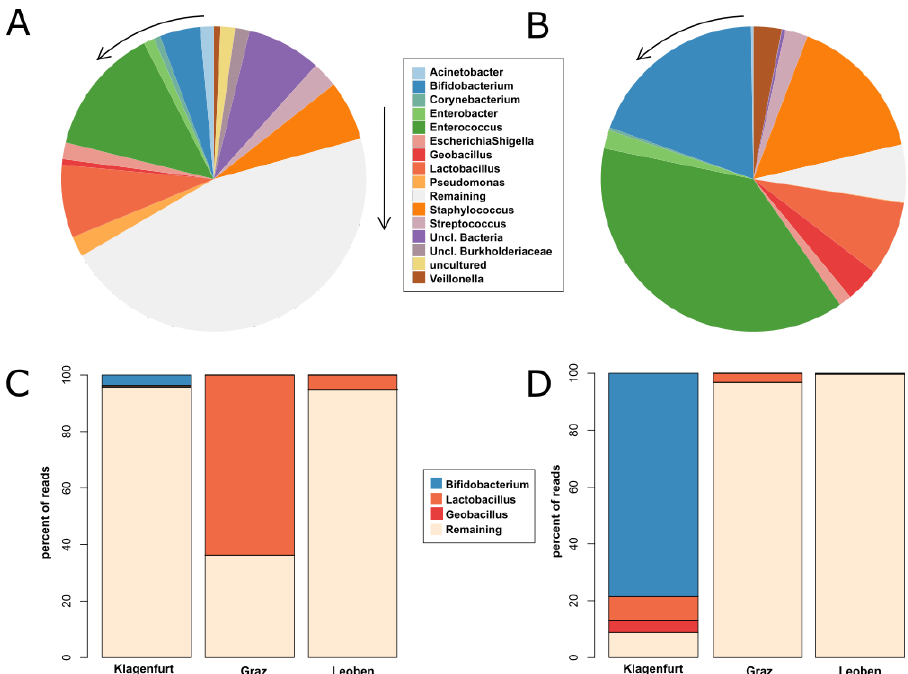
Figure 2. Main bacterial signatures in the premature infants’ gut. ( A ) Pie chart displaying the 15 most abundant microbial genera detected in fecal samples of 54 preterm infants obtained from the three participating centers in the meconium (time points t1 and t2) and ( B ) at time point t6 and t7. ( C ) Relative abundance of signatures from Bifidobacterium, Lactobacillus, Geobacillus and remaining genera in samples from the three centers (K, G and L) at time points t1 and t2 as well as ( D ) at time points t6 and t7.